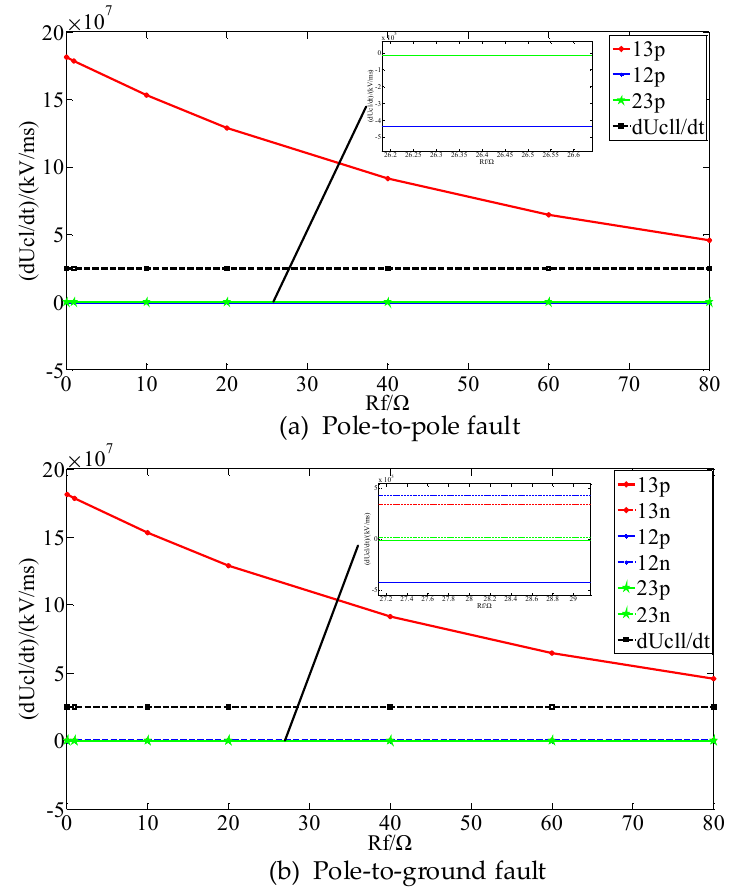
Figure 16. Voltage change rates of the CLIs during DC faults with different fault resistances.